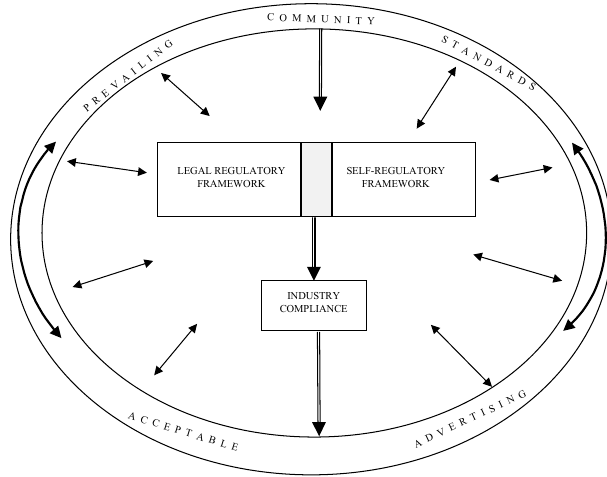
Figure 1: Acceptable advertising: A framework for